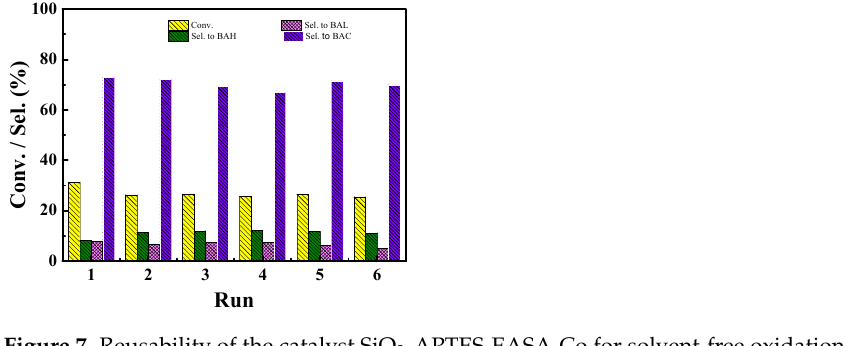
Figure 7. Reusability of the catalyst SiO 2 -APTES-EASA-Co for solvent-free oxidation of toluene via molecular oxygen. Toluene/NHPI (40), NHPI/Co (80), 2.6 MPa, 100 °C, 1 h. BAH: benzaldehyde, BAL: benzyl alcohol, BAC: benzoic acid, DBE: dibenzyl ether.